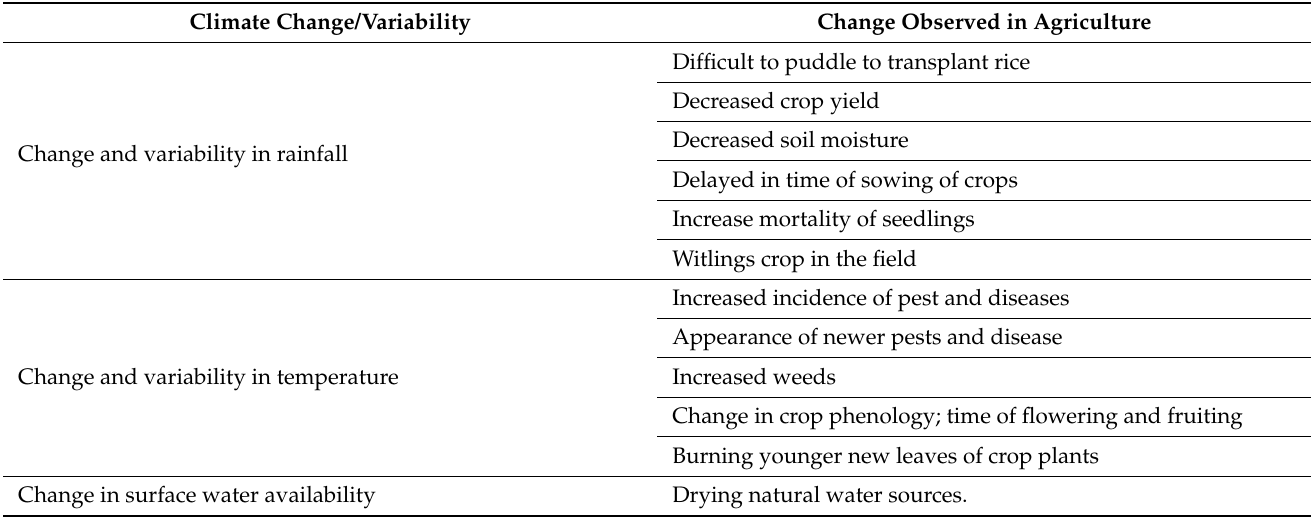
Table 7. Different problems of climate change on agriculture based on climate change indicators as perceived by the farmers in the study